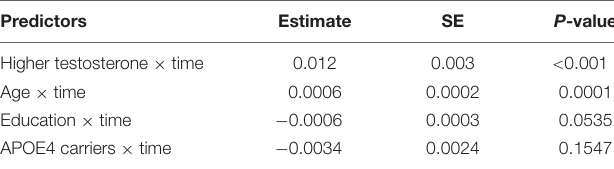
TABLE 2 | Results of linear mixed models in